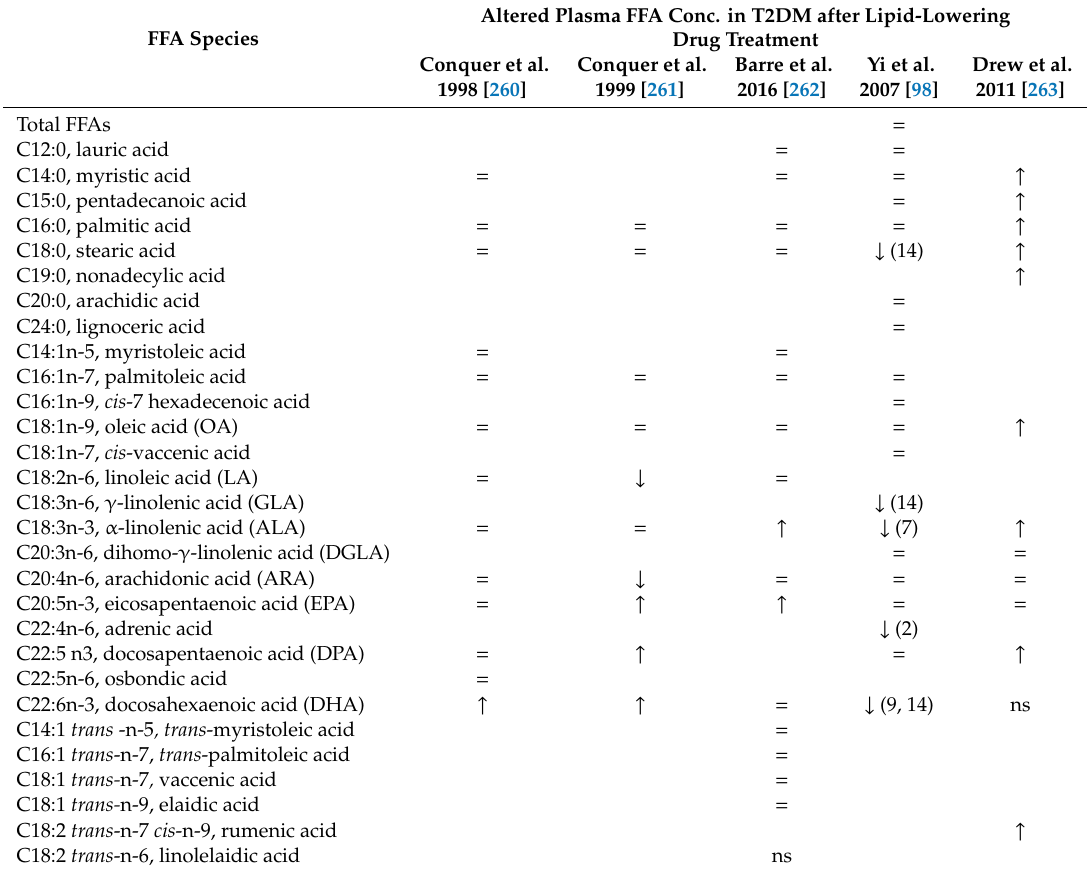
Table 5. Changes in FFA concentrations measured in blood from subjects treated with lipid-lowering drugs. Elevated FFA concentrations are indicated with ↑ , lower concentrations with ↓ , unchanged concentrations with = . The numbers in brackets represent the number of weeks during treatment at which the measurement where made. Altered Plasma FFA Conc. in T2DM after Lipid-Lowering FFA Species Drug Treatment Conquer et al. Conquer et al. Barre et al. Yi et al. Drew et al. 1998 [260] 1999 [261] 2016 [262] 2007 [98] 2011